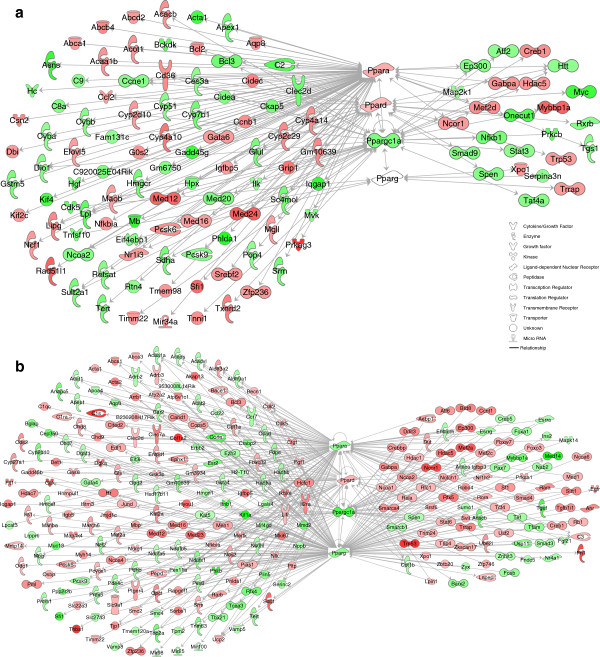
Functional relationship networks of PPAR and PPAR-interacting DEGs responsive to ASP + MSG. IPA-generated networks depict PPAR-interacting DEGs in (a) Liver &(b) Adipose (P < 0.01, stringency ≥ ± 1.4-fold change in expression).